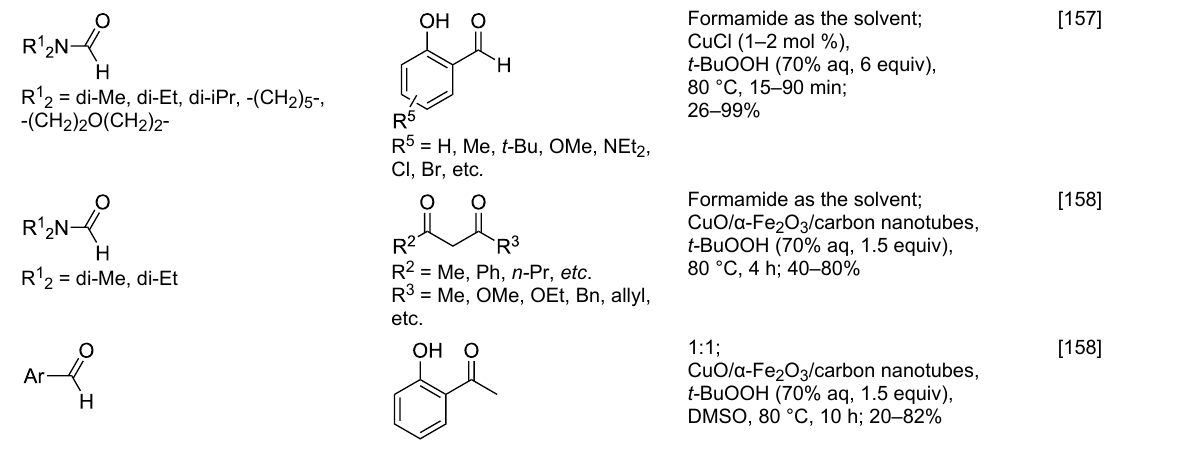
R 1 2 = di-Me, di-Et, di-iPr, -(CH 2 ) 5 -, -(CH 2 ) 2 O(CH 2 ) 2 -